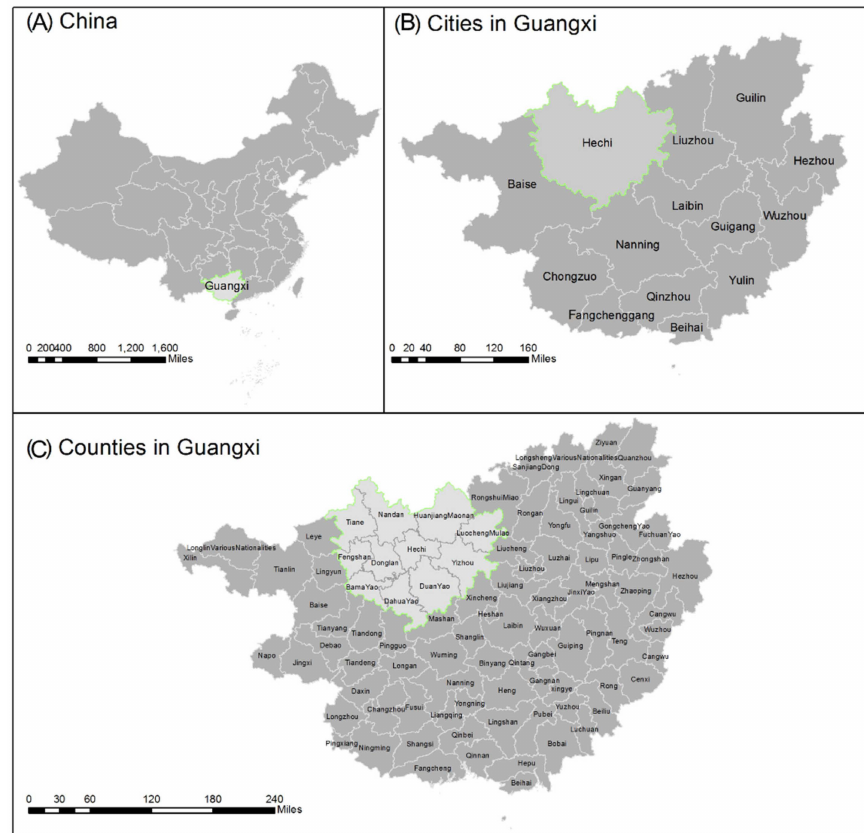
Figure 1. Case study of Guangxi ( B ), ( C ) in China ( A